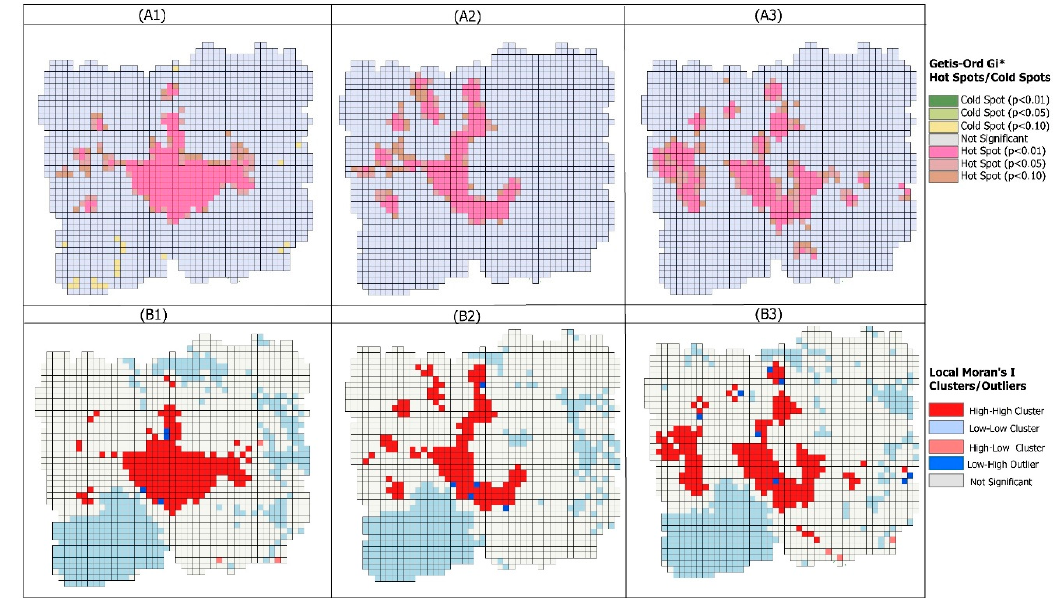
Figure A3. Hotspot and cluster analysis at the unique spatial scale (cell size at 4796 / 4796 m). ( A1 ), ( A2 ), and ( A3 ) represent the hotspot of Getis–Ord Gi* for the period of 22 May, 28 May, and 7 June. Whereas, ( B1 ), ( B2 ), and ( B3 ) represent the LISA analysis of Moran’s I for 22 May, 28 May, and 7 June.